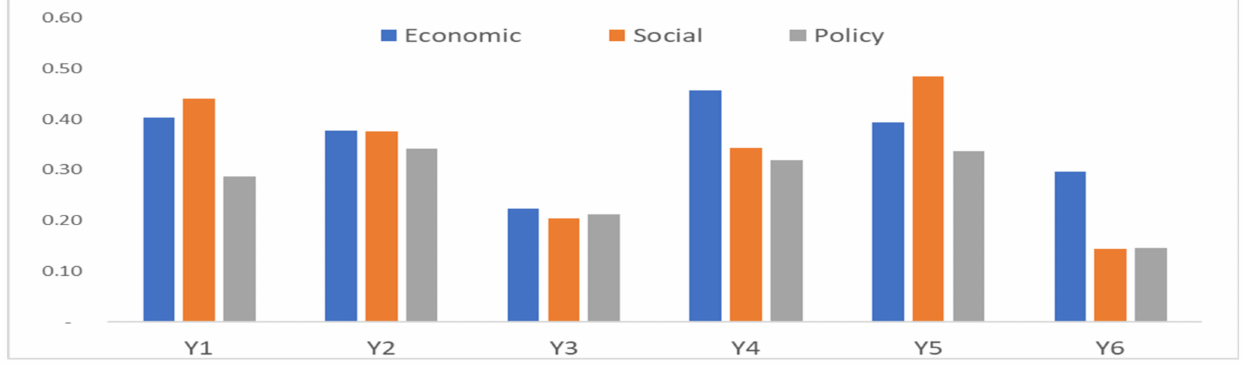
Figure 10. Analysis of driving